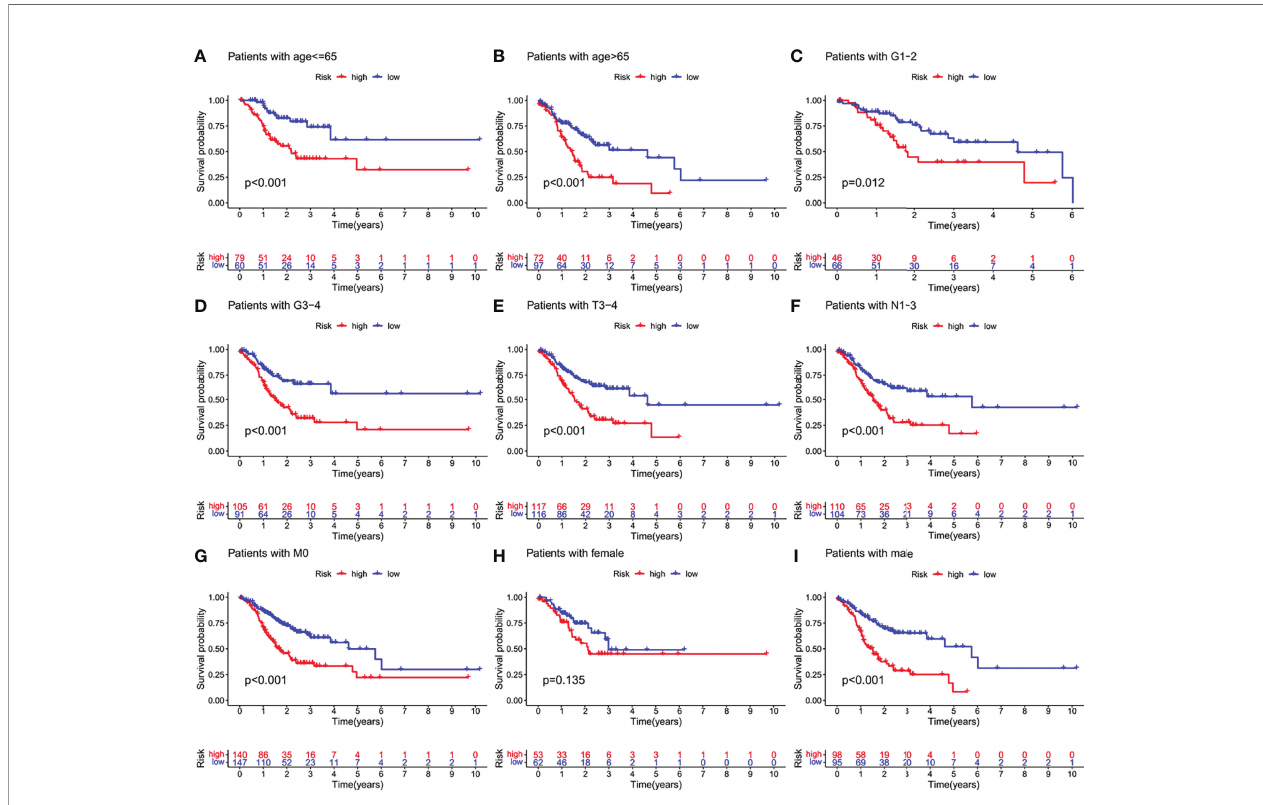
FIGURE 5 | Kaplan-Meier survival curves of GC patients in different clinical subgroups. (A – I) OS survival curves of high and low risk GC patients in age, G1-2, G3-4, T3-4, N1-3, M0, female, male subgroups. OS, overall